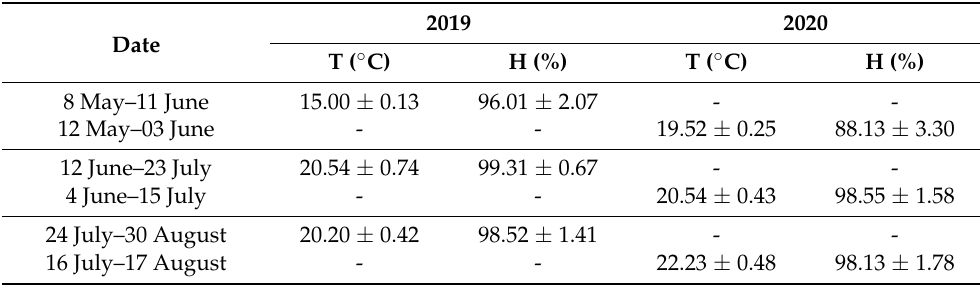
Table 1. Average daily temperature (T) and humidity (H) of soil (mean ± SD) in the experimental plots in the intervals between material collection in 2019 and